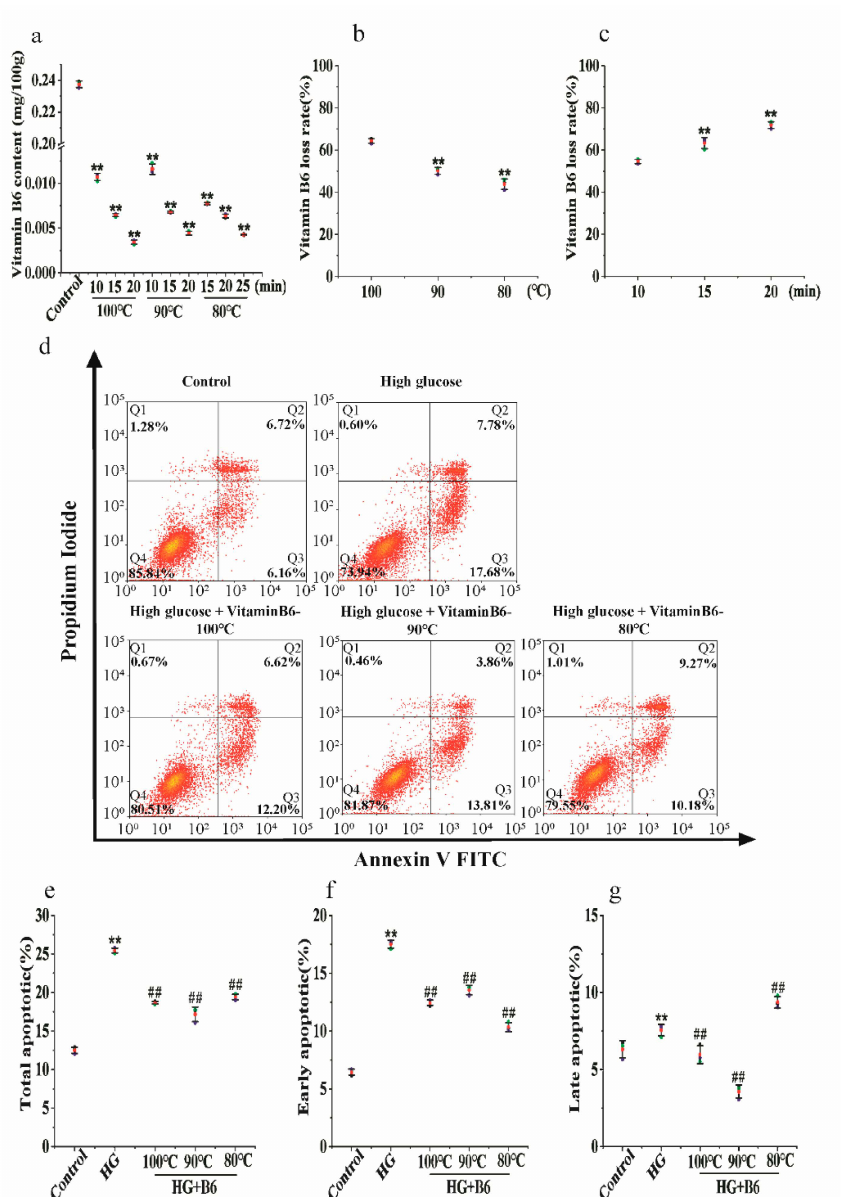
Figure 2. The effect of hydrothermal treatment on the concentration and biological activity of vitamin B6 in eggs. ( a ) Vitamin B6 content was determined after eggs were hydrothermally treated at 80, 90, or 100 ◦ C for the indicated times. ( b ) Vitamin B6 content was determined after the eggs were hydrothermally annealed at 80, 90, or 100 ◦ C for 10 min. ( c ) Vitamin B6 content was determined after eggs were hydrothermally annealed at 100 ◦ C for the indicated times. ( d ) RIN-m5F cells were cultured with or without 20 µ M glucose or with 20 µ M hydrothermally prepared vitamin B6 plus 20 µ M glucose for 36 h, and apoptosis rates were measured by flow cytometry. ( e – g ) Cells were treated as described in ( d ), and total apoptosis, late apoptosis, and early apoptosis rates were analyzed. The experiment was repeated at least three times (Error bars, s.d ** p < 0.01 indicates significant differences compared with the control group by one-way ANOVA. ## p < 0.01 indicates significant differences compared to the high glucose-treated group by one-way